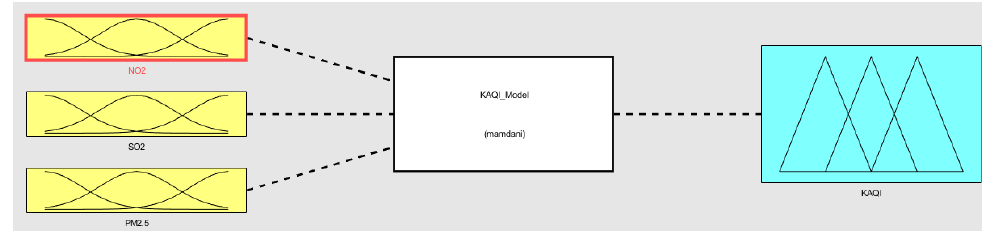
Figure 3. Design of the Air Quality Index prediction model for NO 2 , SO 2 and PM 2.5 vs.